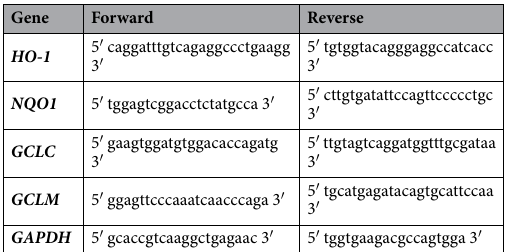
Table 2. Primer pairs used for the quantitative reverse transcription polymerase chain reaction